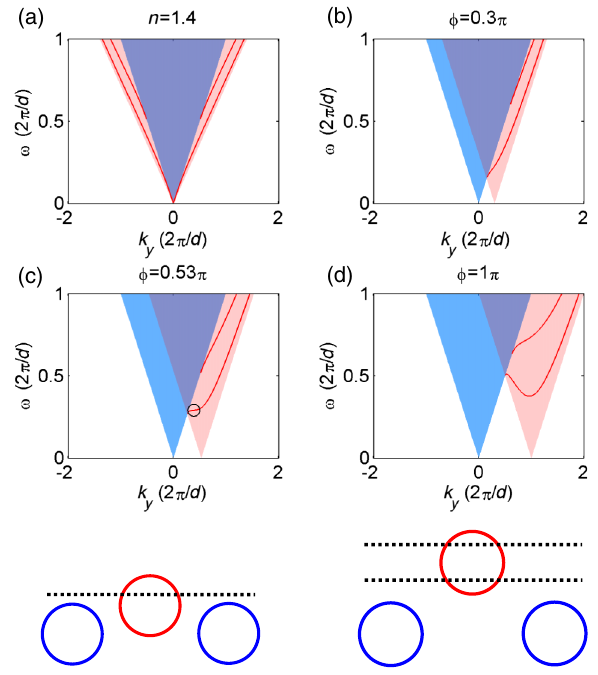
FIG. 2. Dispersion relation of the guided mode (red solid line) for (a) a conventional waveguide with cladding index n ¼ 1 and (c) a gauge-field waveguide with ϕ ¼ 0 . 53 π , with the inflection point [22] marked by a black circle, (d) a gauge-field waveguide with ϕ ¼ π . The pink and blue regions show the light cones for the core and cladding regions, respectively. Isofrequency con- tours for (e) small and (f) large ϕ at the same frequency ω . Panel > 0 while panel (f) has guided (e) has only guided mode with v g > 0 and v < 0 modes with v g g